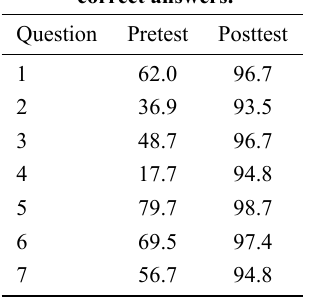
Table 1. Comparison of pretest versus posttest percentage correct